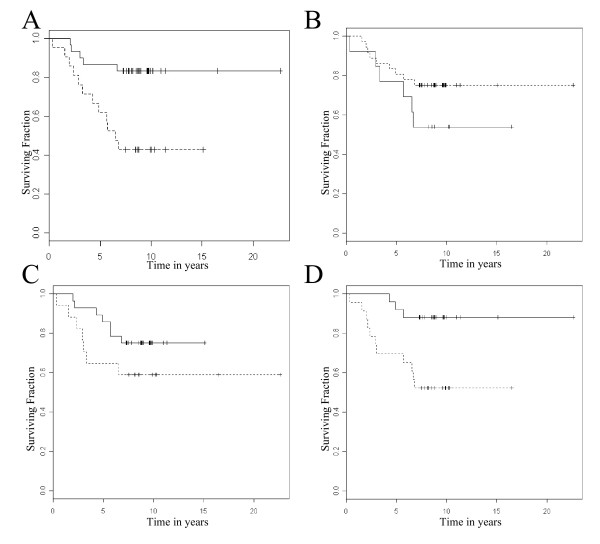
Kaplan-Meier survival curves for UCSF breast tumors based on our predictive gene sets. Surviving fraction of predicted good (solid lines) and poor (dashed lines) groups is shown. A) separation based on 21 gene set (P < 0.0001). B) separation based on ER positive (dashed line) vs. ER negative (solid line) (P = 0.18). C) separation based on grade 1+2 (solid line) vs. grade 3 (dashed line) (P = 0.19). D) separation based on node positive (dashed line) vs. node negative (solid line) (P = 0.005).